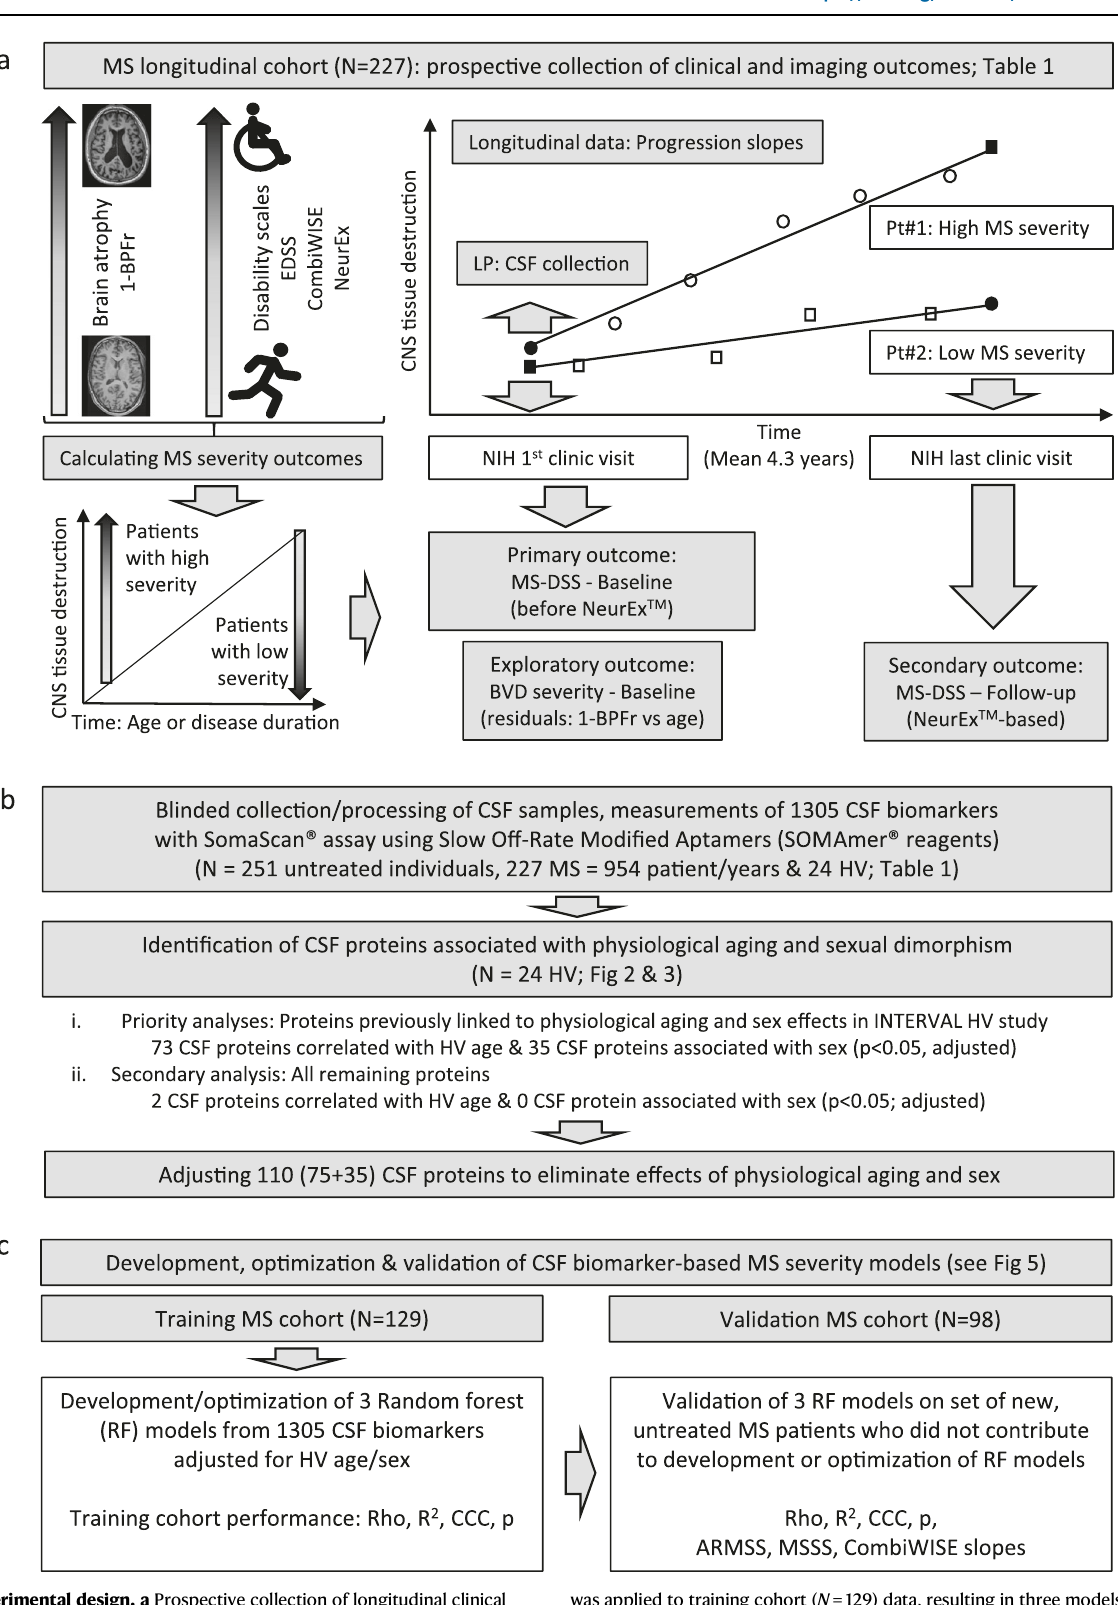
Nature Communications| (2022)